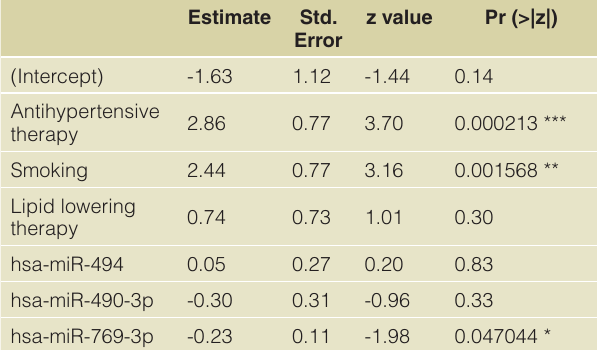
Table 4. Logistic regression analysis using demographic characteristics and significantly differentially expressed